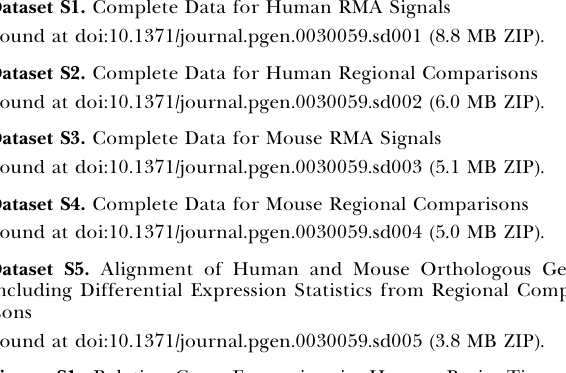
Figure S1. Relative Gene Expression in Human Brain Tissues Is Robust and